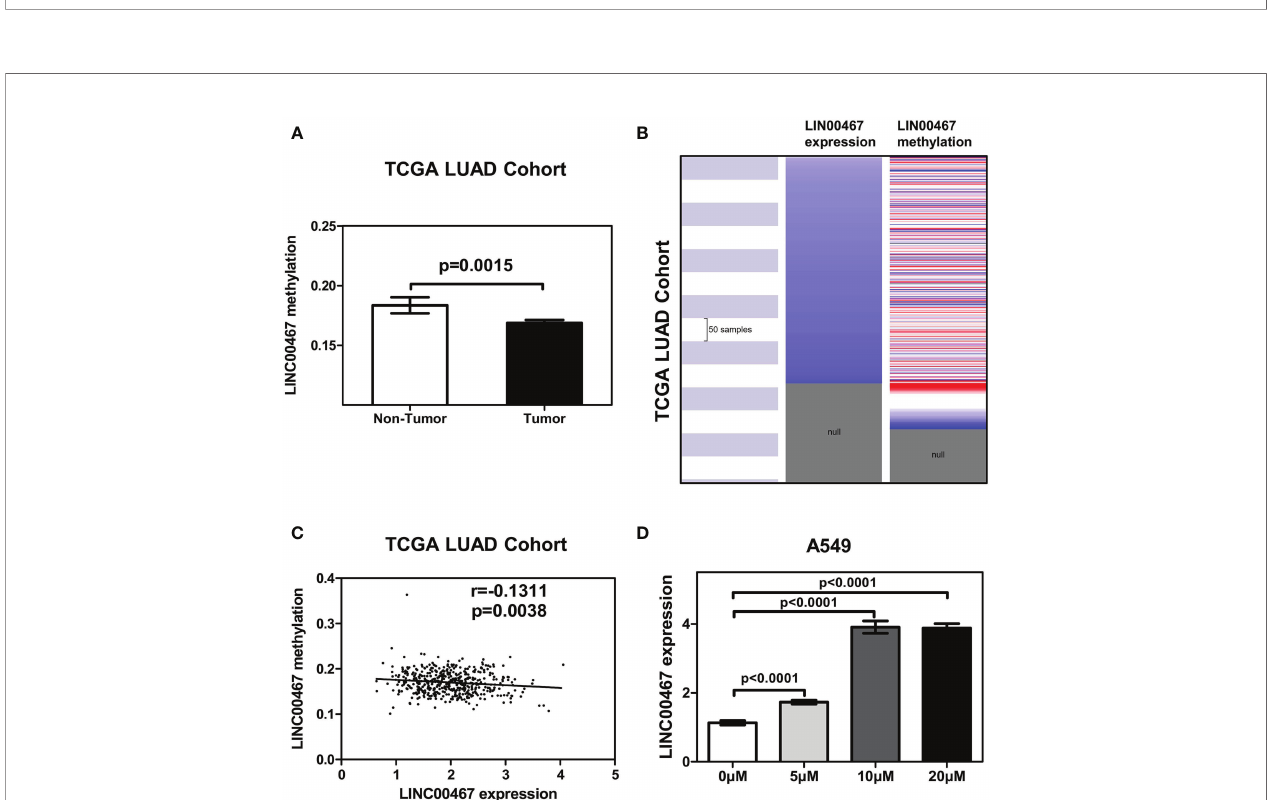
FIGURE 3 | LINC00467 upregulation is modulated by promoter methylation in LUAD. (A) Mean methylation levels of the LINC00467 promoter in tumor versus normal tissues in the TCGA LUAD cohort. (B) Heatmap of LINC00467 expression and DNA methylation in TCGA LUAD cohort. (C) LINC00467 expression negatively correlates with mean LINC00467 promoter methylation levels in TCGA LUAD cohort. (D) LINC00467 expression in A549 cells was signi fi cantly down-regulated in a dose-dependent manner after 5-azacytidine